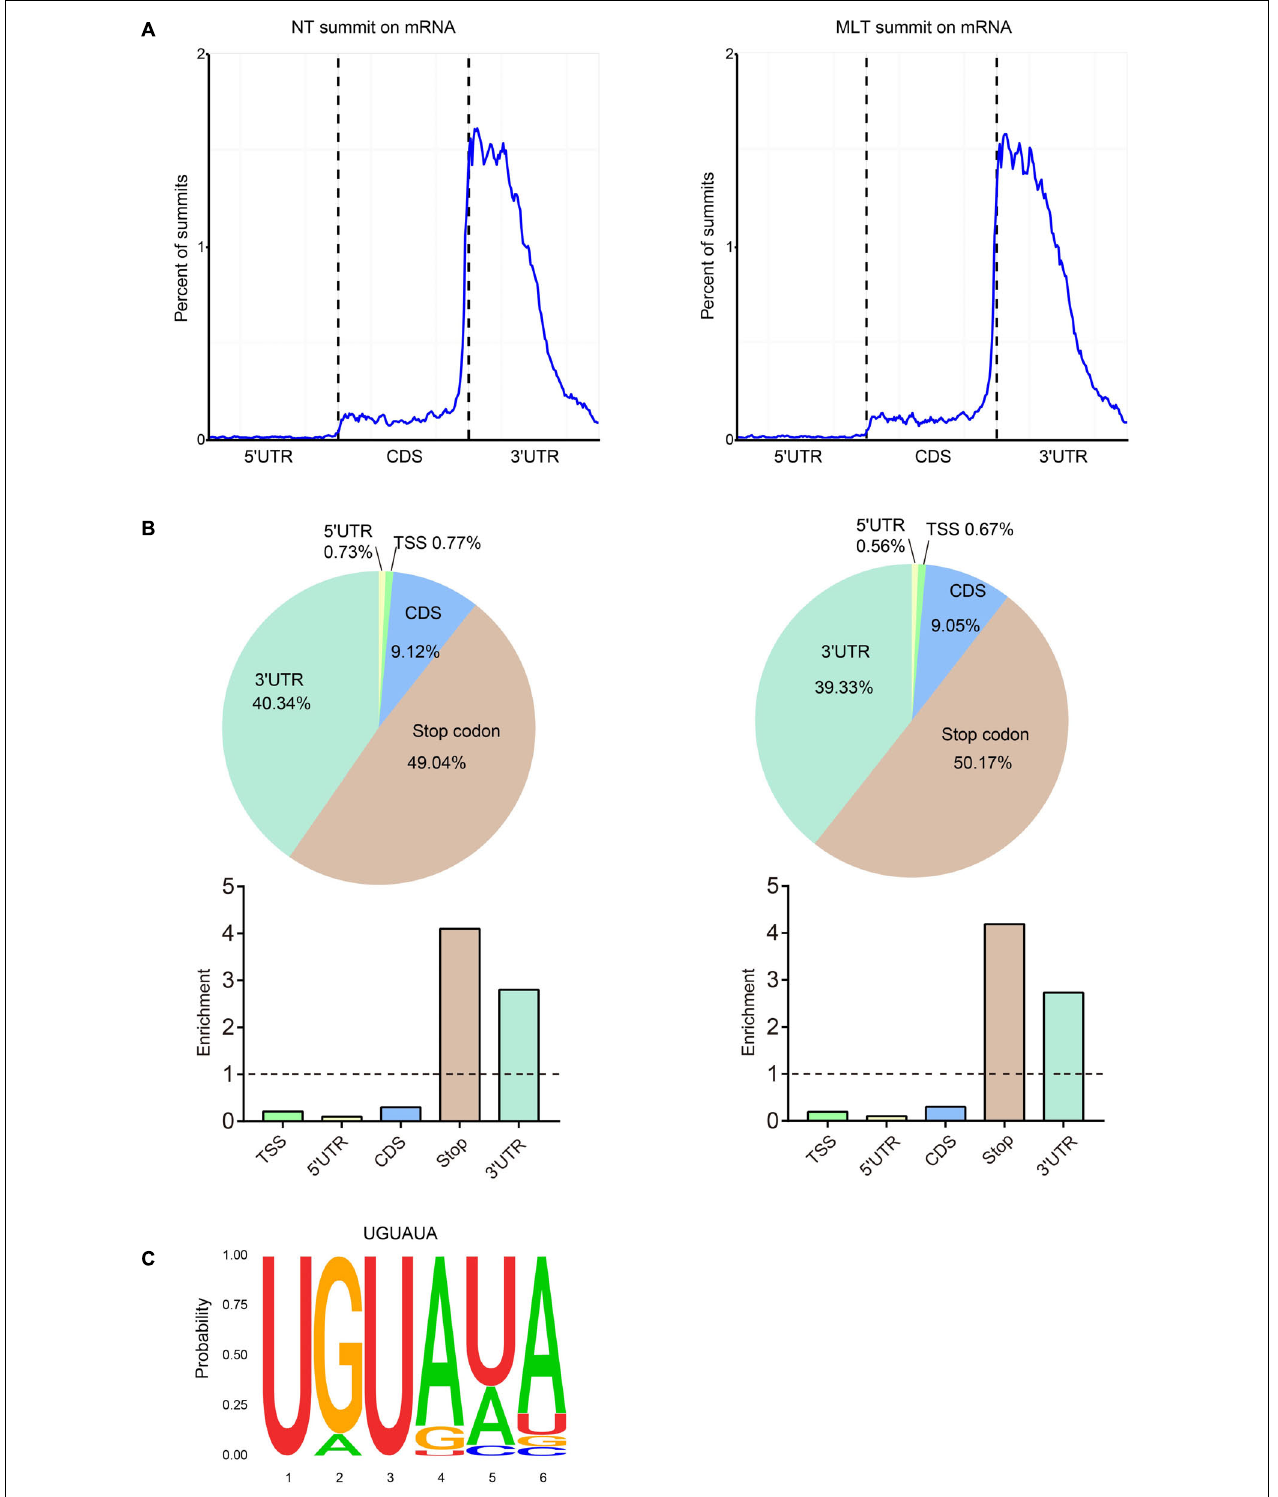
FIGURE 4 | Distribution pattern of m 6 A peaks along the transcripts and the sequence motif in tomato anther. (A) m 6 A peaks summits localization along the transcripts in NT and MLT conditions. Each transcript is divided into three parts: 5 (cid:48) -UTR, CDS and 3 (cid:48) -UTR. UTR, untranslated region; CDS, coding sequence. (B) The m 6 A peaks summits and relative enrichment in five non-overlapping transcripts segments in NT and MLT conditions. TSS, transcription start site. (C) The conserved sequence motif for m 6 A peaks in NT and MLT conditions.